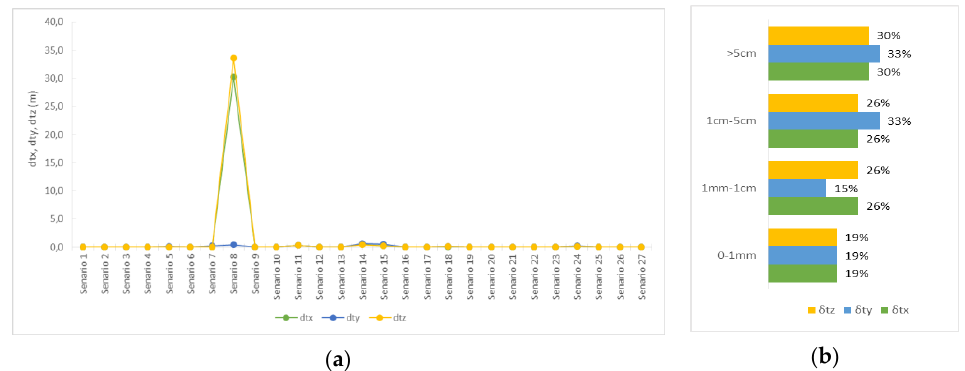
Figure 7. ( a ) Deviations in meters for translation per axis in the dual-quaternion method. ( b ) Histogram of deviations for translation per axis in the dual-quaternion method.